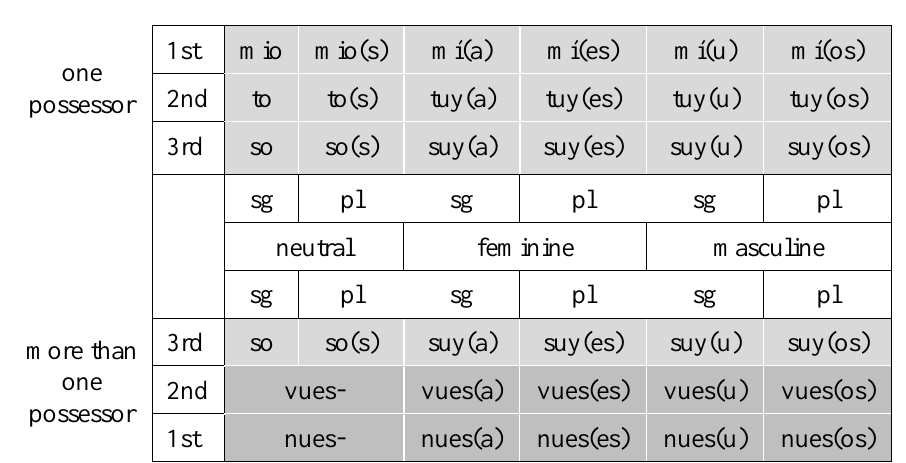
Table 2. Inflectional paradigm of the Asturian possessives. Pale gray: with free neutral; dark gray: without free neutral.